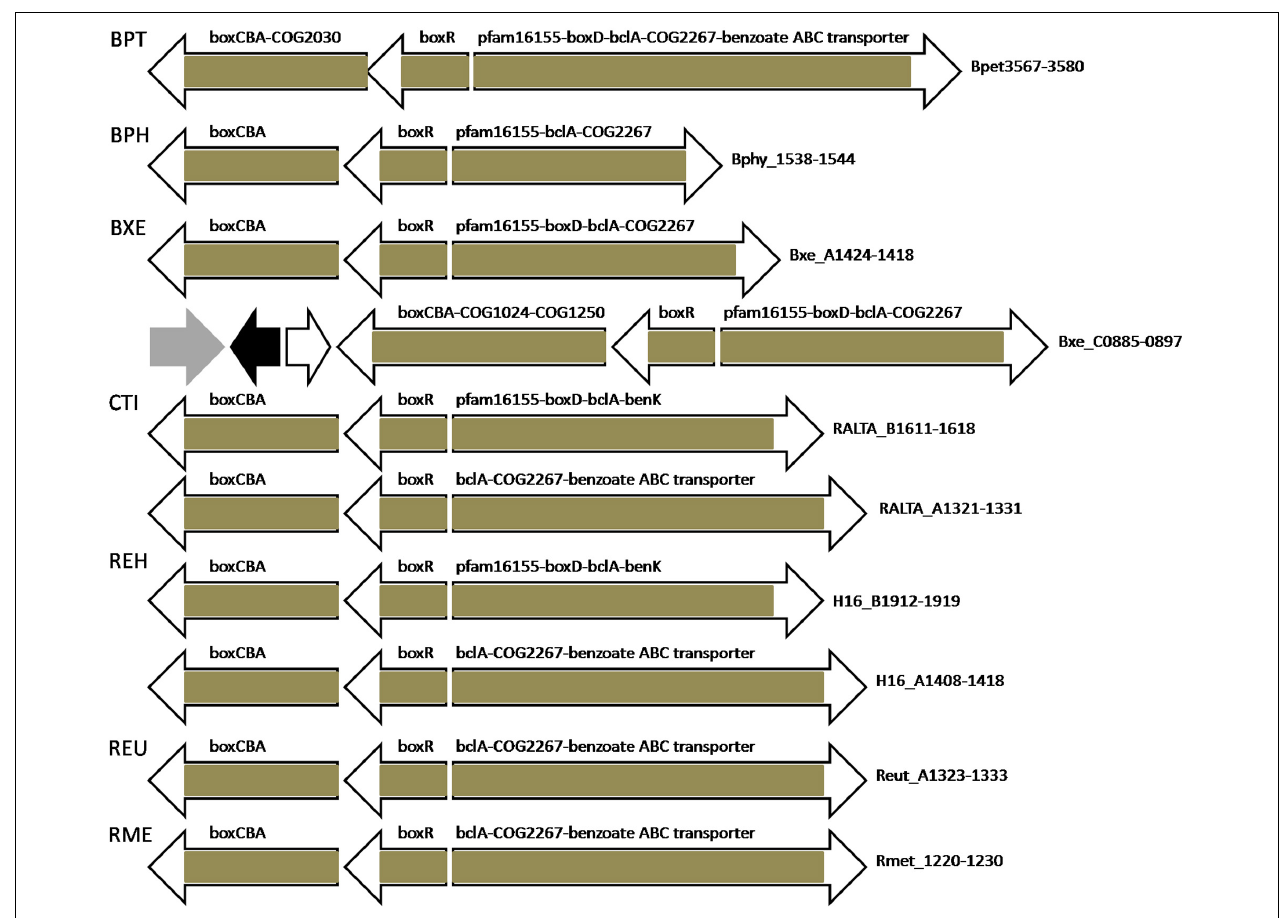
FIGURE 6 | Operon organization and regulation of aromatic metabolism genes regulated by BoxR/BzdR in B. petrii DSM 12804, Burkholderia spp., and Ralstonia spp. Brown color denotes regulation by BoxR/BzdR. Genes/operons are shown by arrows, black arrows denote pseudogenes, gray – transposases. Genome abbreviations as in Supplementary Table S2